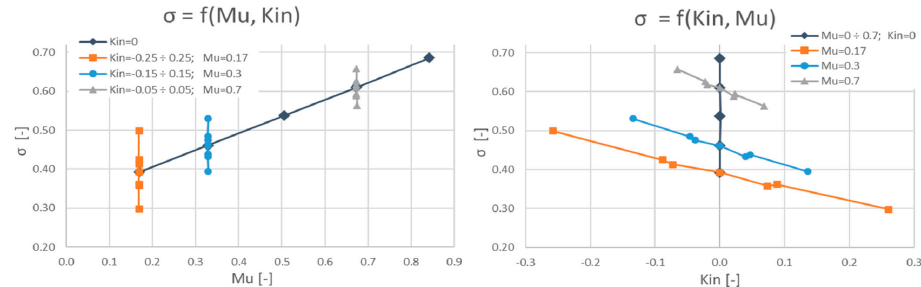
Figure 8. Windage heating against the circumferential Mach number and inlet pre-swirl ratio.